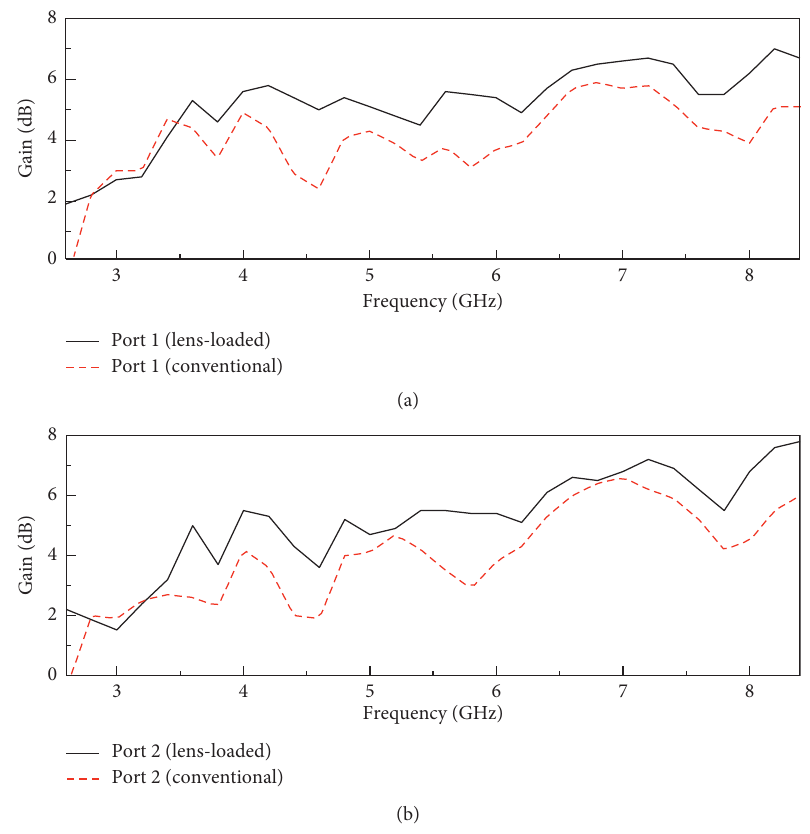
Figure 6: The measured normal gain data of (a) the conventional and (b) lens-loaded FRHAs.